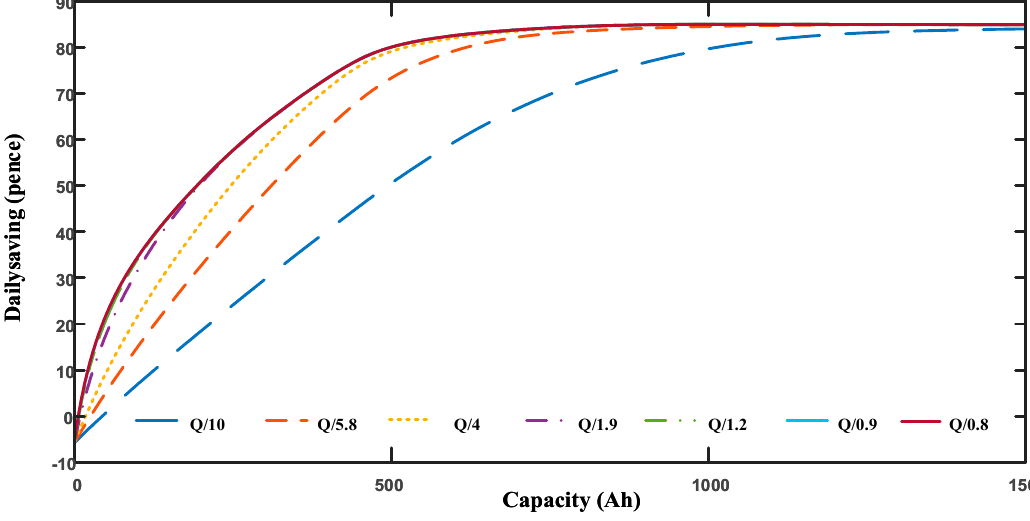
Figure 7. Daily energy cost saving vs. battery capacity at different discharge currents (light discharge).